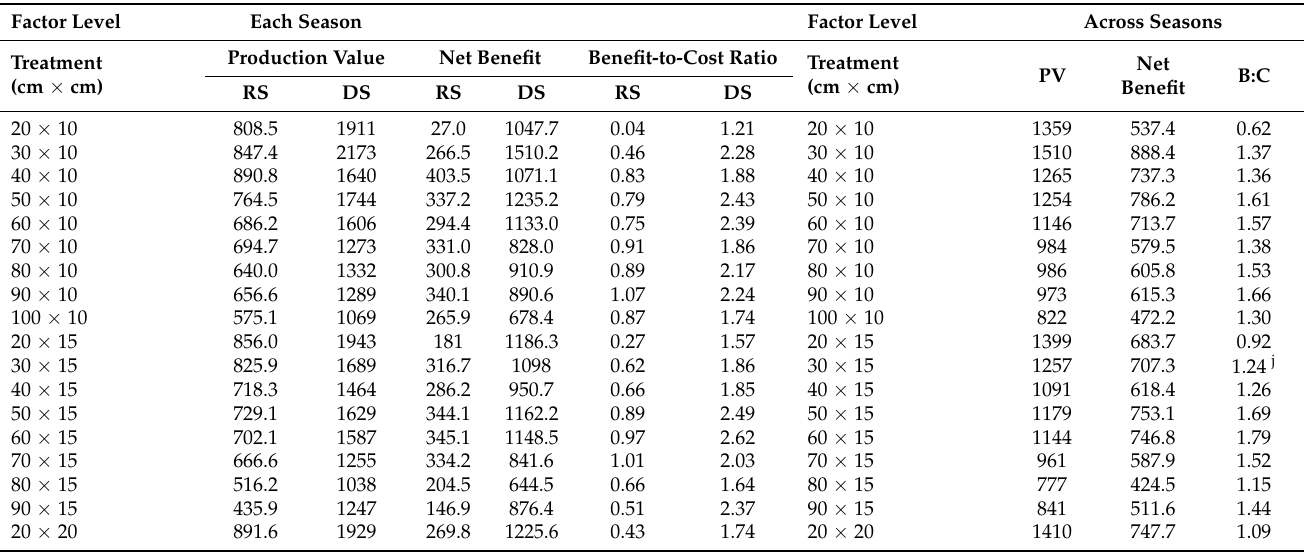
Table 9. Production value (USD), net benefit (USD), and benefit-to-cost ratio of spacing treatments for each season and across